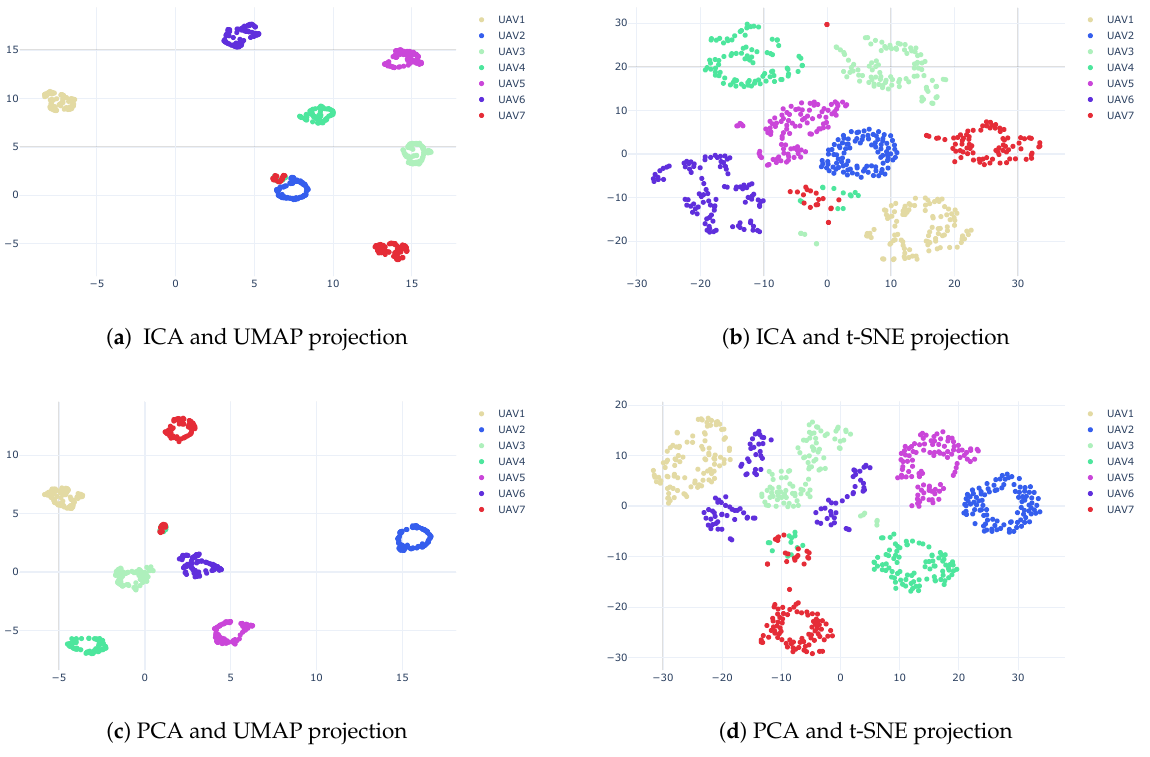
Figure 19. Clustering results using linear and nonlinear techniques for CWT